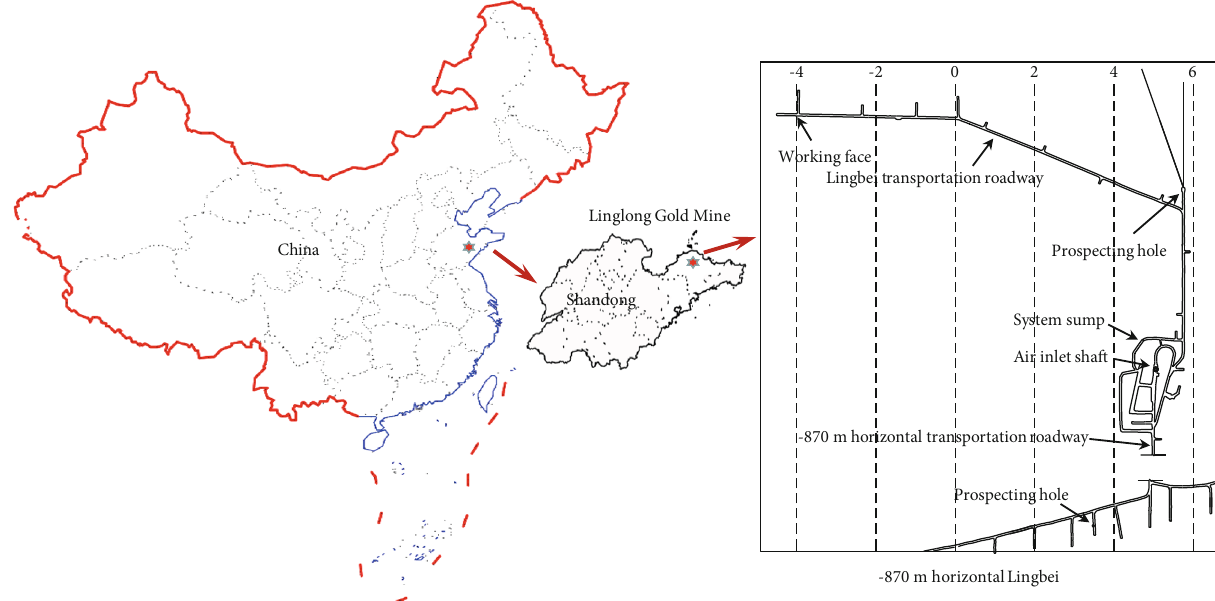
Figure 1: The -870 m horizontal Lingbei